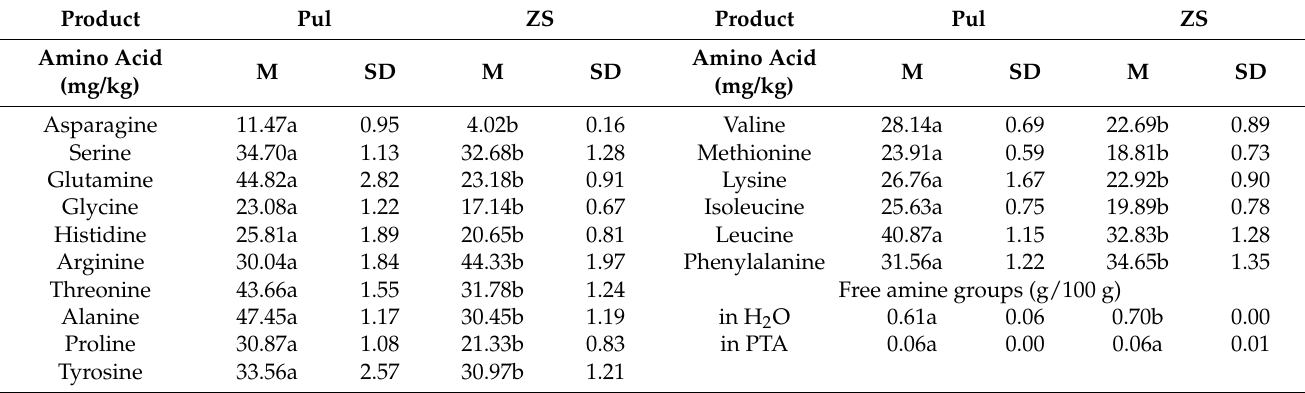
strains of coagulase-negative staphylococci isolated during industrial Spanish dry-cured ham processes could produce some biogenic amines, including histamine, putrescine, cadaverine, and tyramine. Table 2. One-factor analysis of the variance of the free amino-acid content of dry-cured ham.